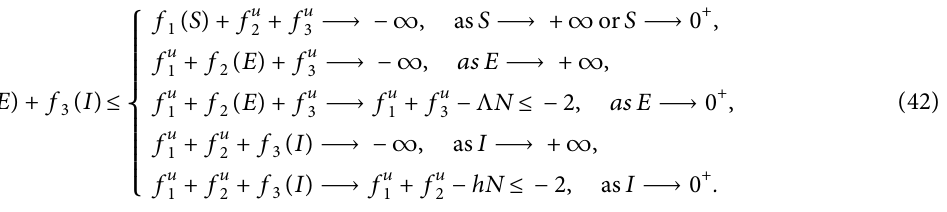
( t ) , E ( t ) ,I ( t ) is the solution to the stochastic model 1 1 1